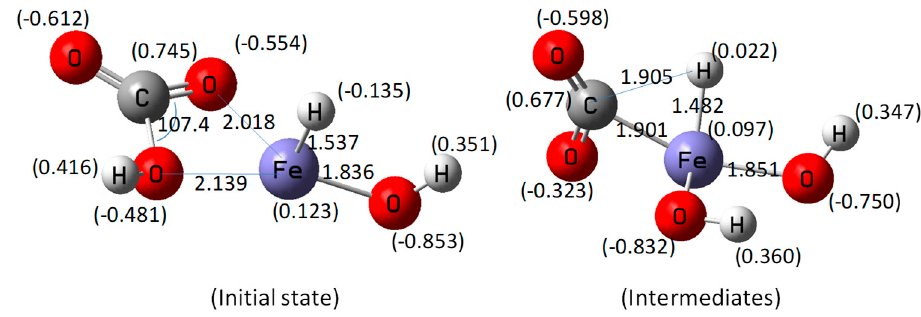
Figure 1. Optimized geometric parameters of the initial state and the intermediate state.